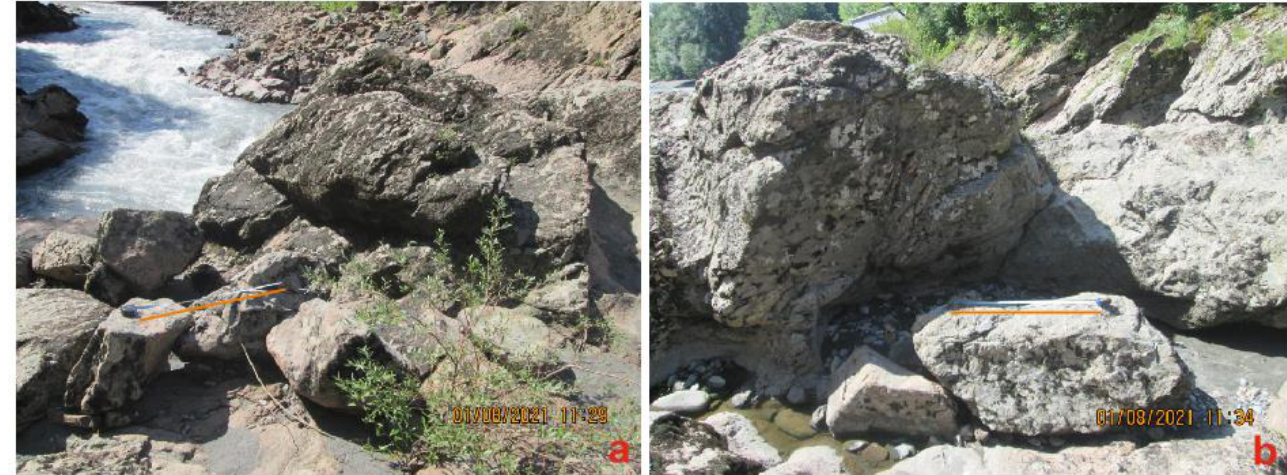
Figure 4. Large clasts from the study plot: ( a ) accumulation of coarse boulders, ( b ) small megablock ( right ) and coarse boulder ( left ) (the tape highlighted in orange indicates 1 m).